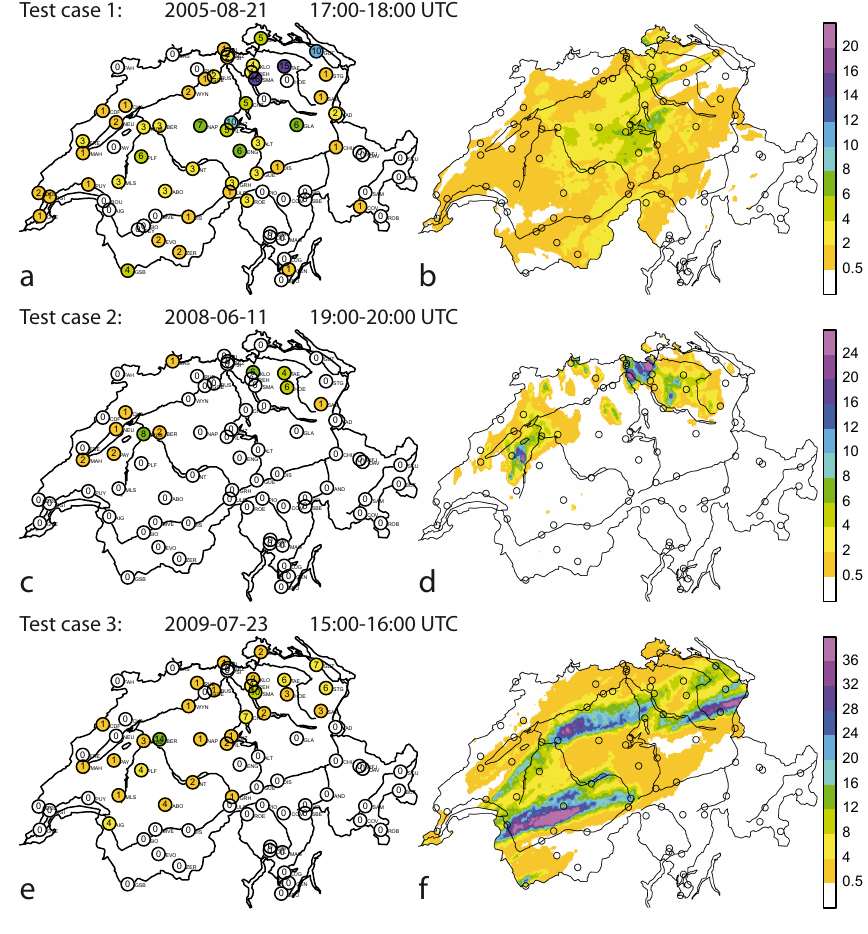
Fig. 5. Test cases considered in this study. (a, c, e) Hourly raingauge accumulations, (b, d, f) hourly radar accumulation; all in mm. (a, b) August 2005 floods (test case 1), (c, d) EURO 2008 flooding (test case 2), (e, f) fast and heavy thunder cells with hail over the Swiss Plateau (test case 3).